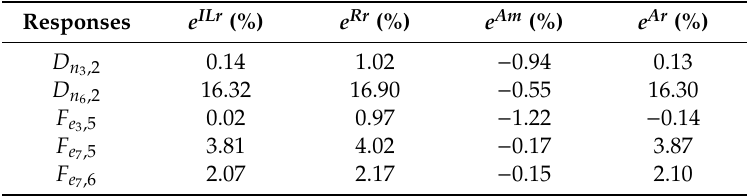
Table 7. Error ratio of responses when different modelling methods are used.